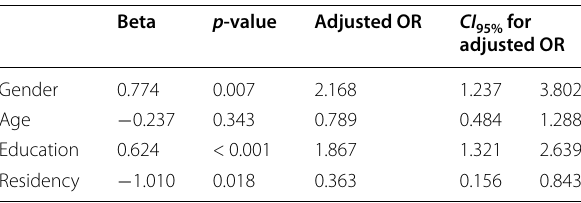
Table 4 Logistic regression analysis of service utilization associates